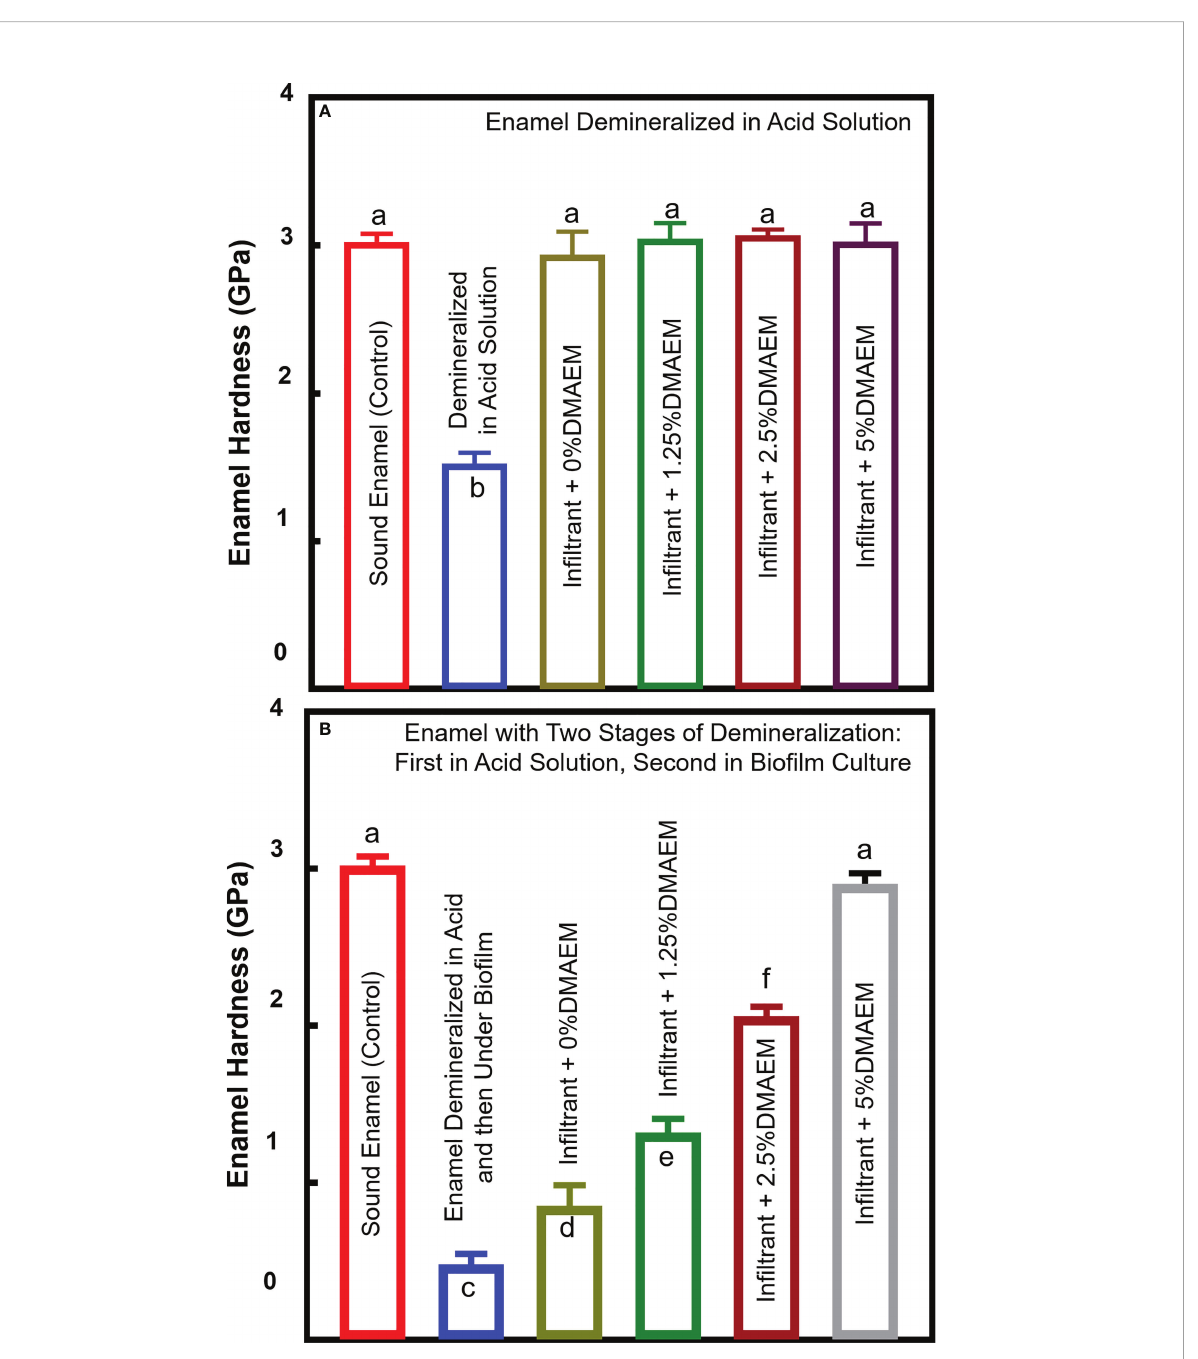
FIGURE 7 Enamel hardness. (A) Enamel samples were demineralized in acid solution, after then, in fi ltrant was applied as Figure 1. (B) Enamel samples were fi rst demineralized like (A) and after in fi ltration, all the samples were second demineralized under bio fi lm (mean ± SD; n = 6). The different letters indicate the signi fi cant difference between the bars (a, b, c). The resin in fi ltration showed similar hardness value of sound enamel (p > 0.05), and after bio fi lm attack, only the hardness of the in fi ltrant + 5% DMAEM group did not decrease (p >